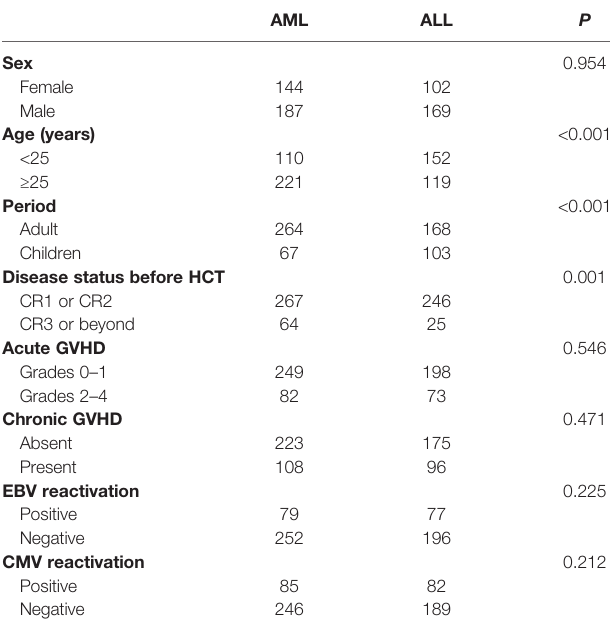
TABLE 1 | Characteristics of patients between the AML group and the ALL group.